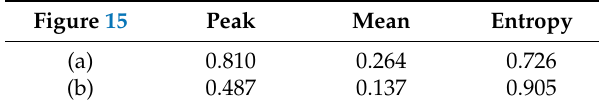
Table 7. Results of MPSM jamming in Figure 15.